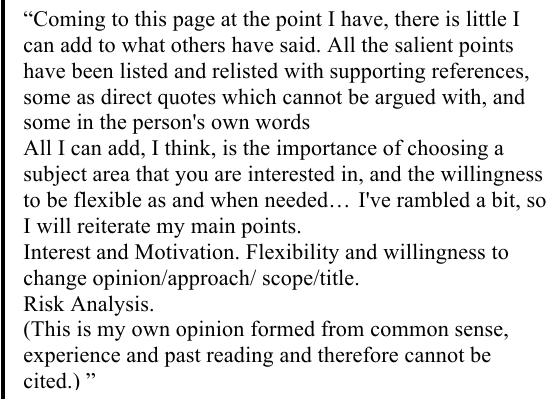
Figure 3. Critical thinking through synthesising credible information